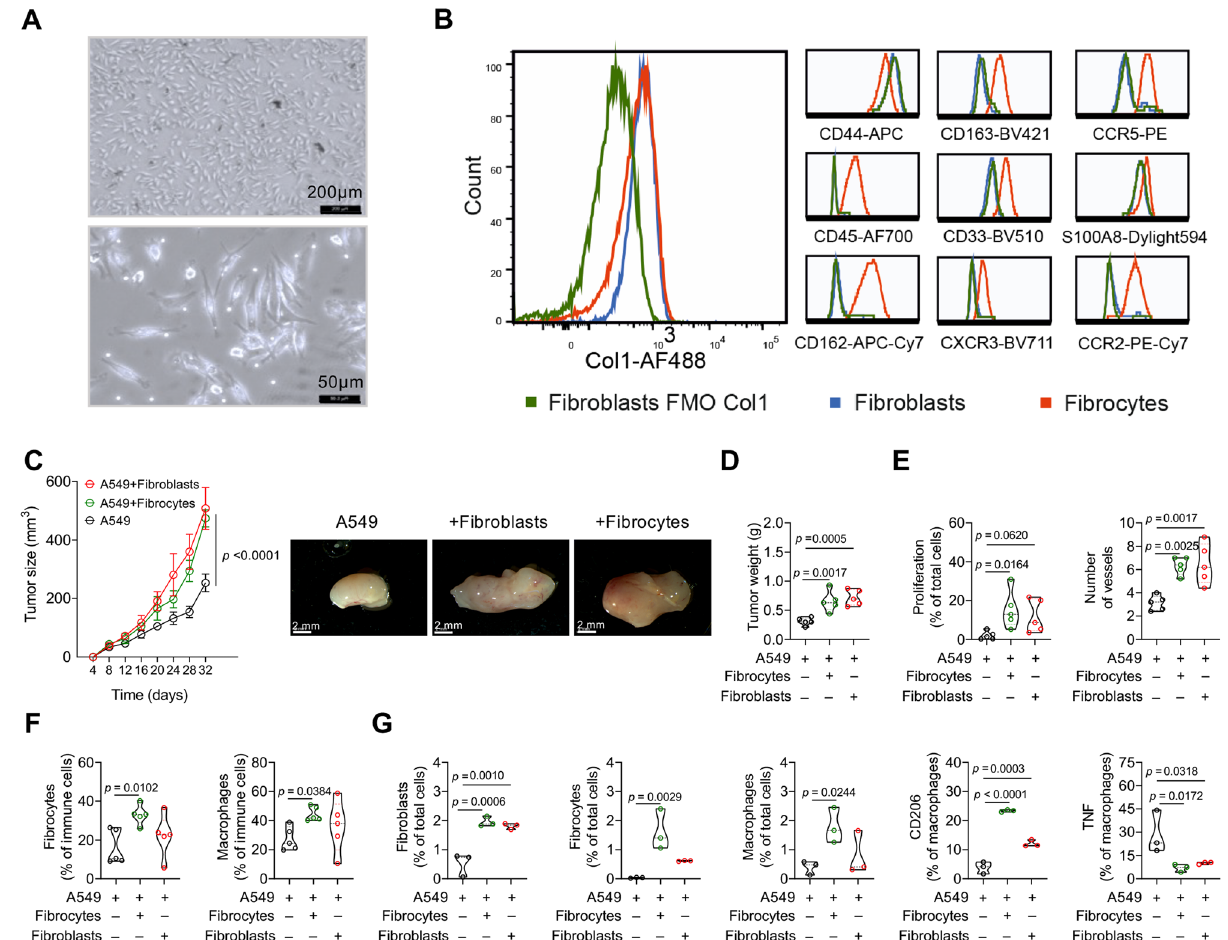
Fig. 5 | Co-injection of fi brocytes and fi broblasts with lung cancer cells aug- mentstumorgrowth. Human fi brocyteswereisolatedfromPBMCs. A Fibrocytes were depicted by bright fi eld microscopy with different magni fi cations ( n =10, scale bar, 200 µ m, and 50 µ m). B Representative fl ow cytometry plots show the purity of fi brocytes using CD45 + , Col1 + , CD44 + , CD163 + CCR5 + , CD33 + , S100A8 + CD162 + , CXCR3 + , CCR2 + as markers compared to fi broblasts. Col1 fl uorescence minus one (FMO) control indicates ef fi cacy of the Col1 antibody. C – G Co- injection of human lung cancer A549 cells with fi brocytes and fi broblasts into BALB/c nude mice. C Tumor size from mice injected with A549 (cancer cells) alone or co-injected with fi brocytes and fi broblasts. p values were determined usingTwo-wayANOVAwithFisher ’ sLSDtest, n =5.Representativepictures(scale bar, 2mm) and ( D ) tumor weight of tumors from mice injected with A549 or co- injected with fi brocytes and fi broblasts after 32 days. n =5, p -values were deter- mined using One-way ANOVA with Fisher ’ s LSD test. E Quanti fi cation of PCNA +